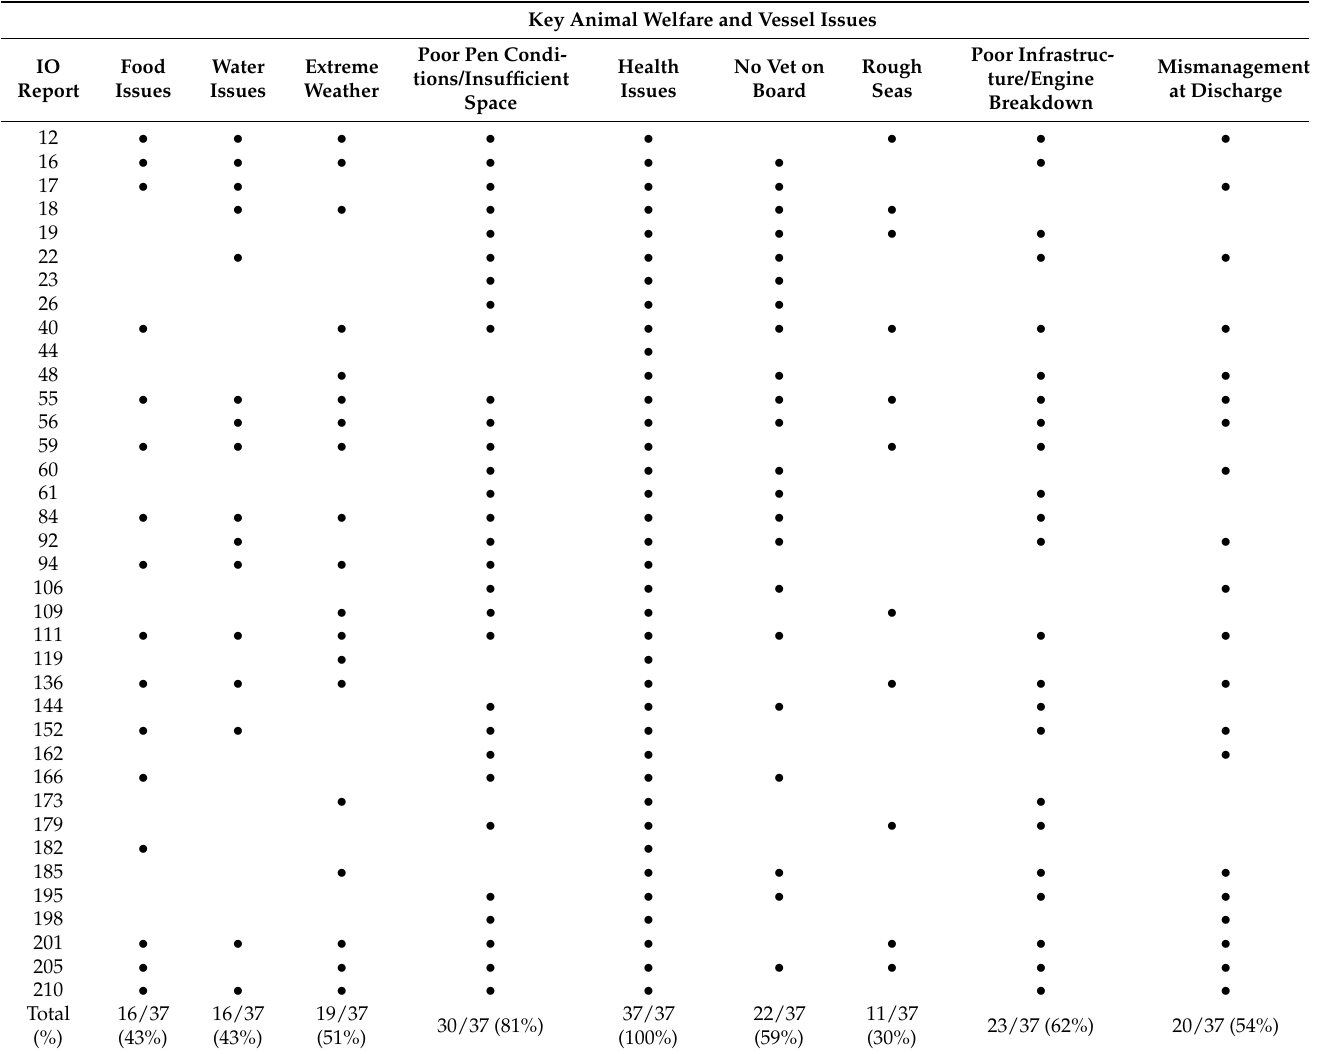
Table 1. Key animal welfare and relevant vessel issues in live cattle export voyages from Australia to China in 2018/2019 identified from Independent Observer